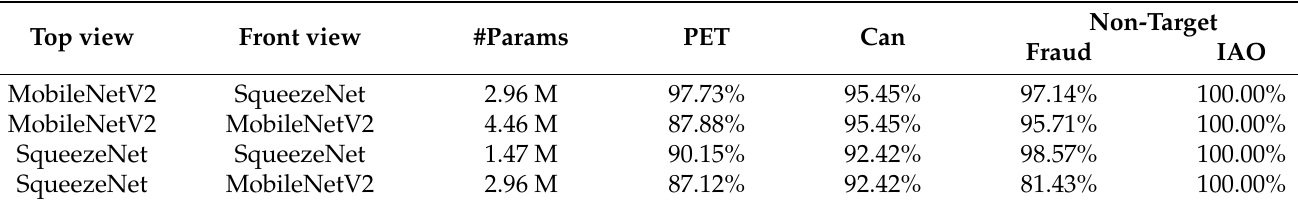
Table 6. Performance of CNN ensemble models trained with top view and front view data simultaneously, classifying objects into PET, Can, and non-target